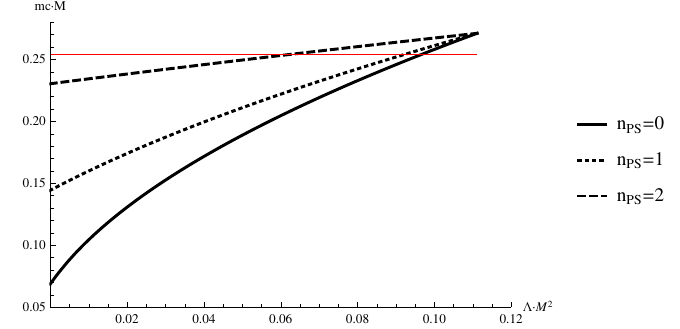
Figure 7 . The behaviour of m c M as a function of (cid:3) M 2 for di(cid:11)erent values of the overtone number n PS = 0 ; 1, and 2. For values of the critical mass below the horizontal red line the zero mode is subdominant at the critical mass, while it is dominant at the critical mass for values above the